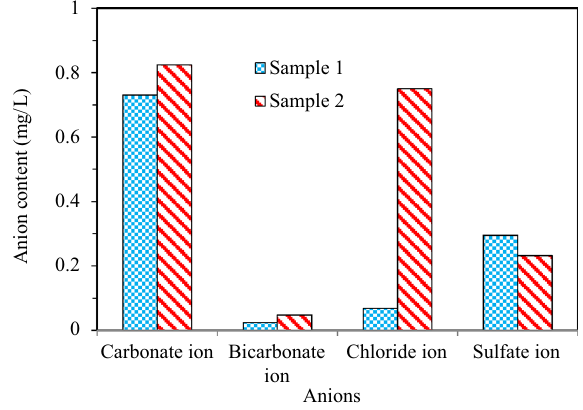
Figure 6. Anions content in fly ash.